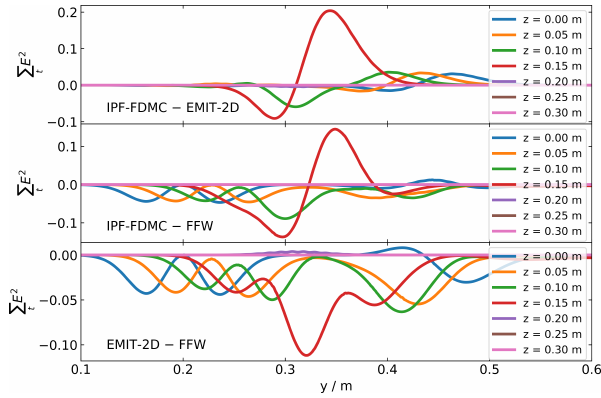
Figure 8. Full-wave simulation results for scenario #6, shown is a snapshot of the squared wave electric